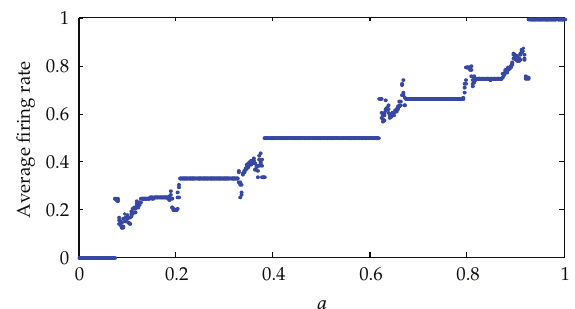
Figure 1: The average firing rate of the chaotic neuron.